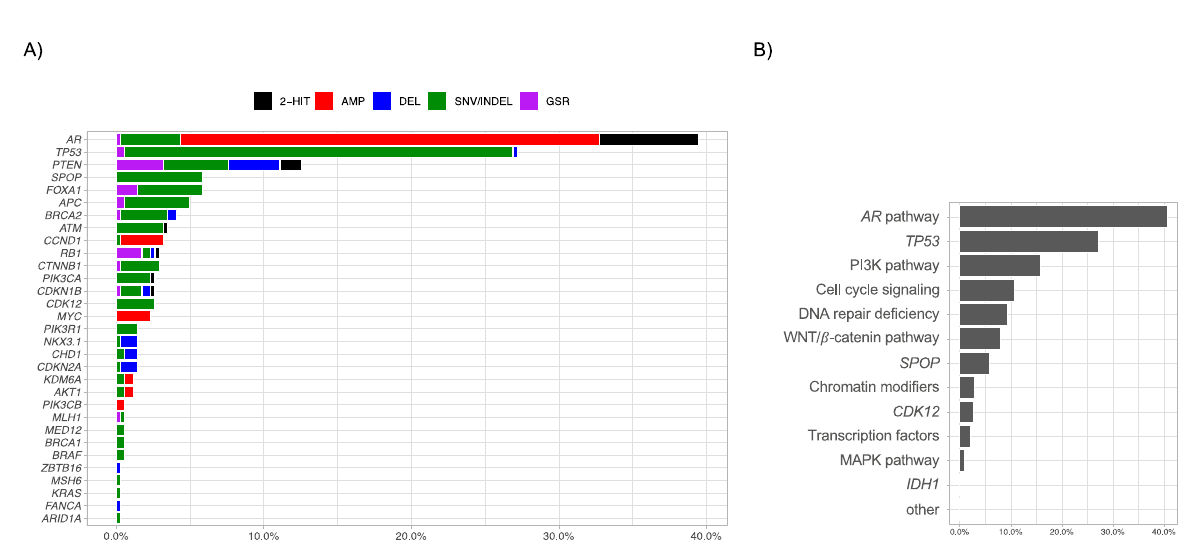
Figure 2. Prevalence of genomic alterations in baseline plasma ctDNA samples from patients with metastatic castration- resistant prostate cancer-initiating abiraterone or enzalutamide ( n = 342). ( A ) Gene-level alteration frequencies, colour-filled according to perturbation type. ( B ) Pathway or gene class-level alteration frequency. Abbreviations: AMP, amplification; DEL, deletion; SNV/INDEL, single nucleotide variation, insertion or deletion; GSR, genomic structural rearrangement.